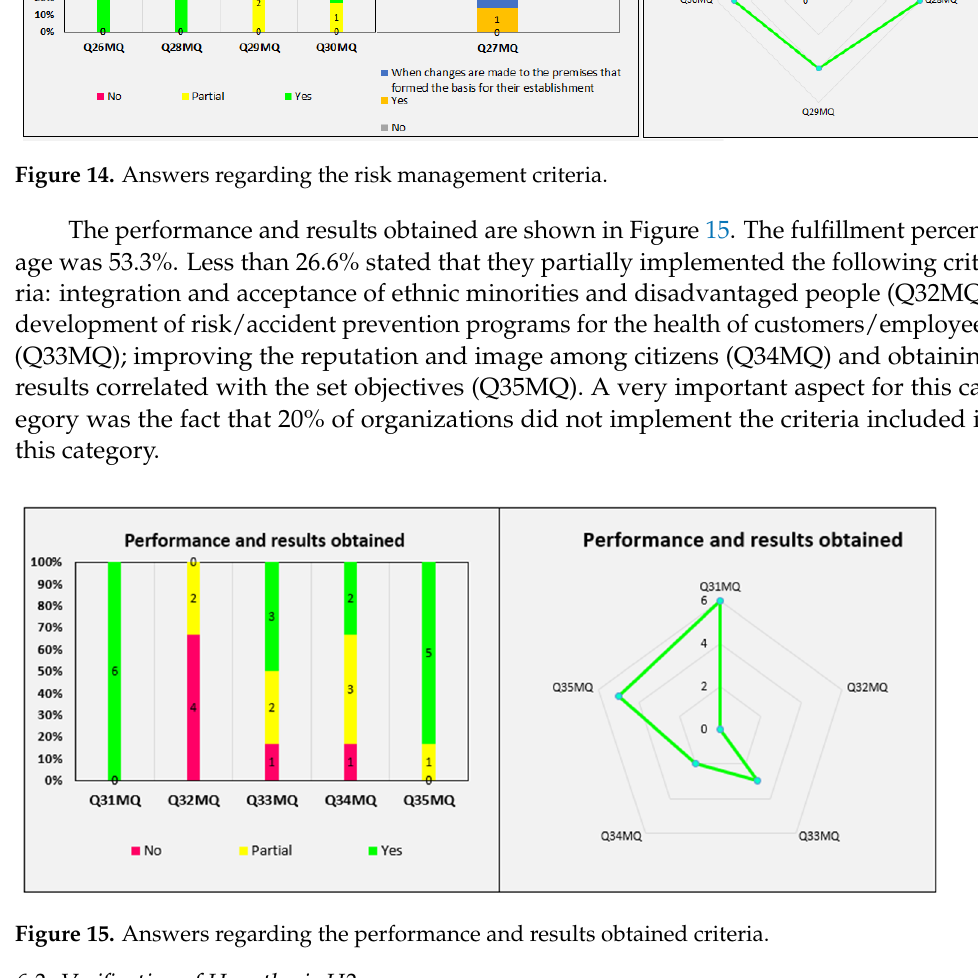
Figure 15. Answers regarding the performance and results obtained